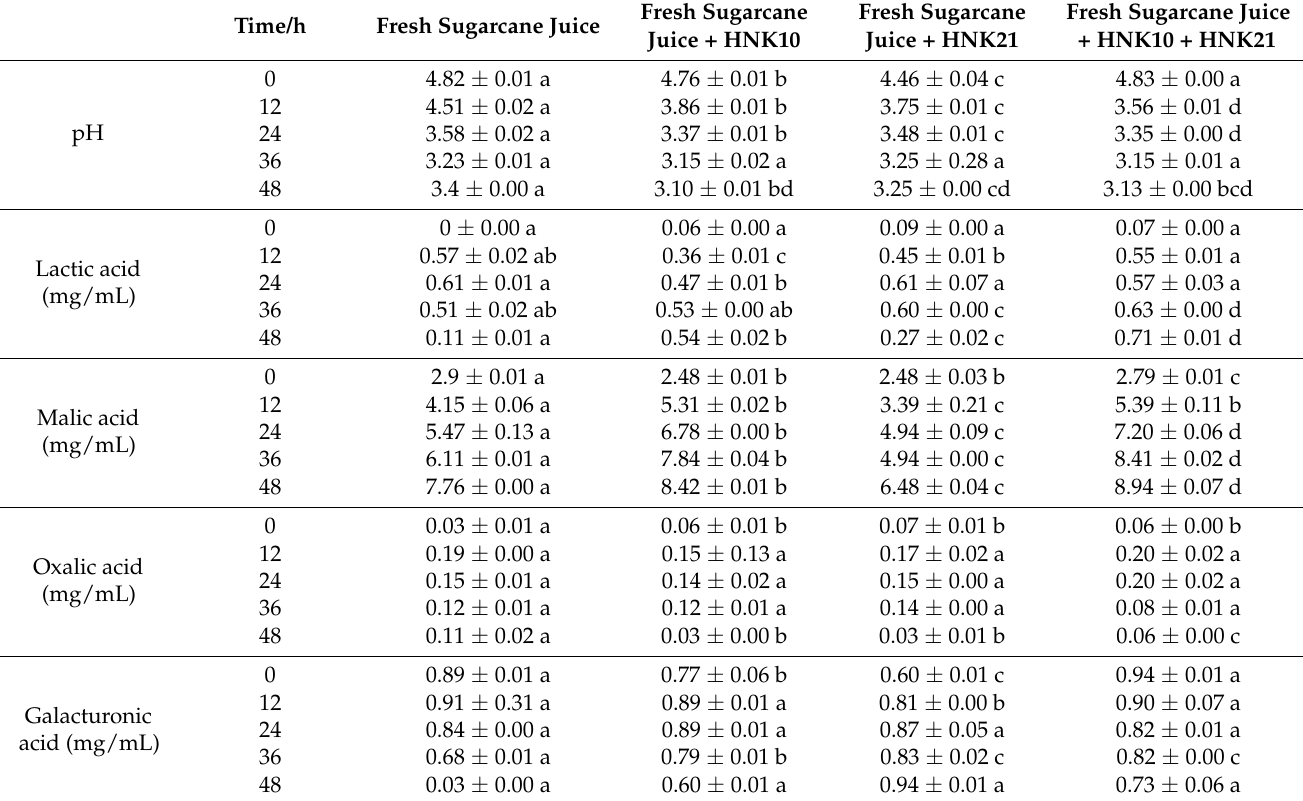
Table 2. Changes in pH and organic acids during sugarcane juice